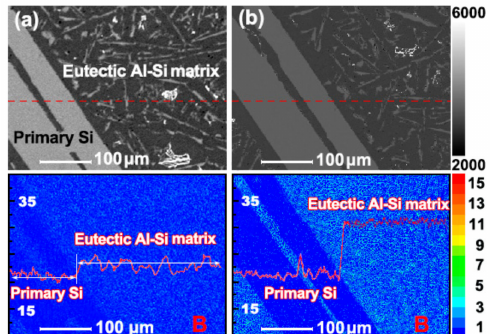
Figure 6. The distribution of impurity B at the interface of primary Si / eutectic matrix measured by electron probe microanalyzer (EPMA): ( a ) without and ( b ) with RMF of 25 mT.